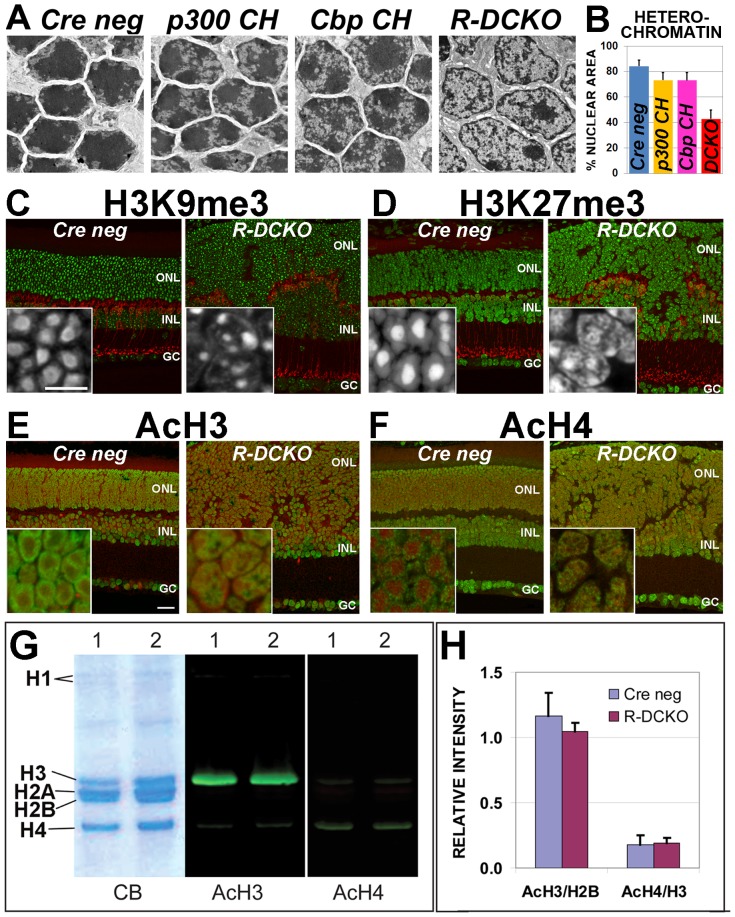
Loss of p300/CBP leads to chromatin decondensation and changes in distribution of histone marks in R-DCKO nuclei.
A. Electron micrographs of nuclei in the ONL of P22 retinas. Compared to Cre neg control littermates, compound heterozygotes (p300 CH and Cbp CH) show slight increases in euchromatin (light areas within nuclei). In R-DCKO nuclei areas of euchromatin are greatly increased, and electron-dense heterochromatin appears reduced. B. Heterochromatin was quantified as a percentage of the total nuclear area in 50 nuclei from 10 micrographs for each genotype. Error bars  = 1 SD. Differences from Cre neg values were significant at p<0.0001. C & D. Comparison of immunoreactivity patterns for repressive histone marks H3K9me3 (green in panel C, white in insets) and H3K27me3 (green in panel D, white in insets) in control (left image) and R-DCKO (right image) retinas confirm loss of the characteristic rod chromatin condensation pattern in R-DCKO outer retina cells. Anti-PKC-alpha (red) marks bipolar cells. E & F. Comparison of immunoreactivity patterns for acetylated histone H3 (AcH3, green in panel D) and H4 (AcH4, green in panel E) reveals the redistribution of these activation marks in R-DCKO cells, corresponding to loss of the characteristic peripheral rod euchromatin distribution pattern. DNA is counterstained with Draq-5 (red). Scale bars: cross-sections  = 20 µm, insets  = 10 µm. G. Western blots of acid-extracted retinal histones from 15-week-old Cre-negative (1) or R-DCKO (2) retinas. CB, Coomassie blue stained gel. AcH3, blot stained for acetylated histone H3; AcH4, blot stained for acetylated histone H4. H. Quantification of band fluorescence intensities for AcH3 levels relative to total H2B levels, and AcH4 levels relative to total H3 levels at P20 did not show significant differences between Cre neg and R-DCKO samples.